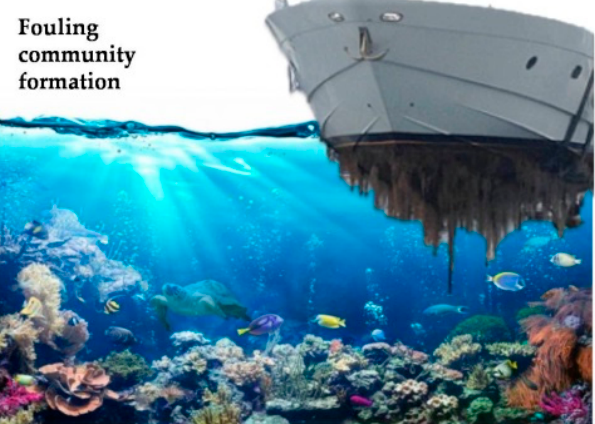
Figure 8. Illustration of the undesirable accumulation of marine biofouling on artificial surface immersed in seawater.